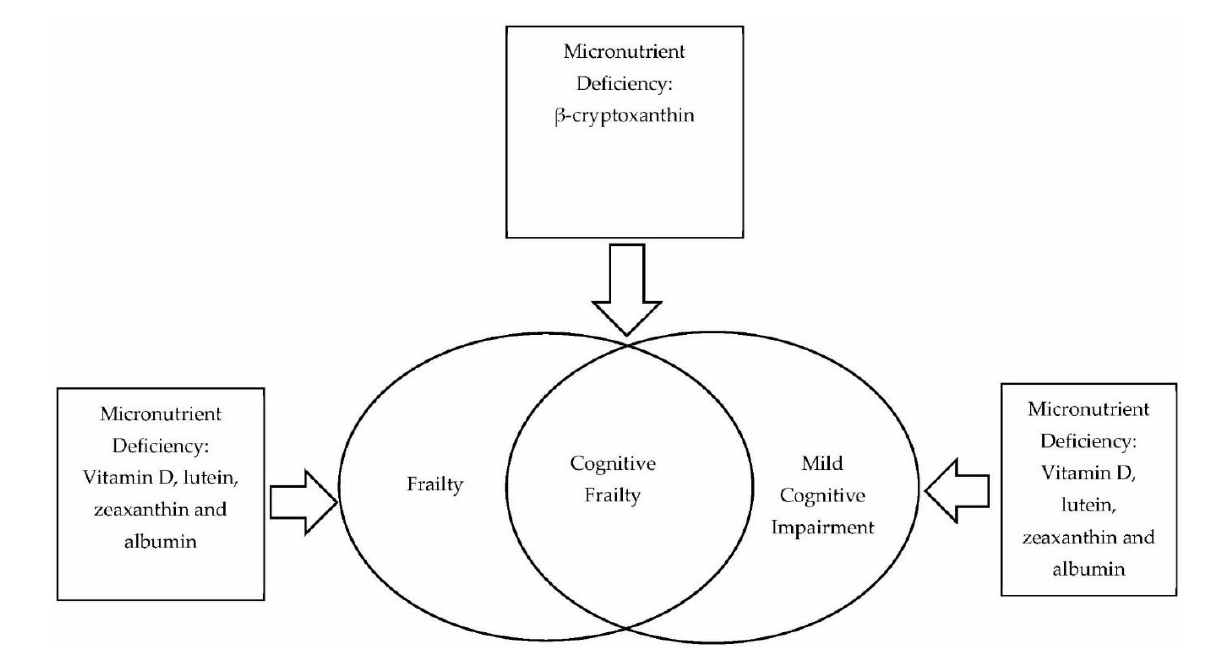
Figure 2. Summary of findings on the association between micronutrient malnutrition and mild cognitive impairment, frailty, and cognitive frailty involved in the elderly.